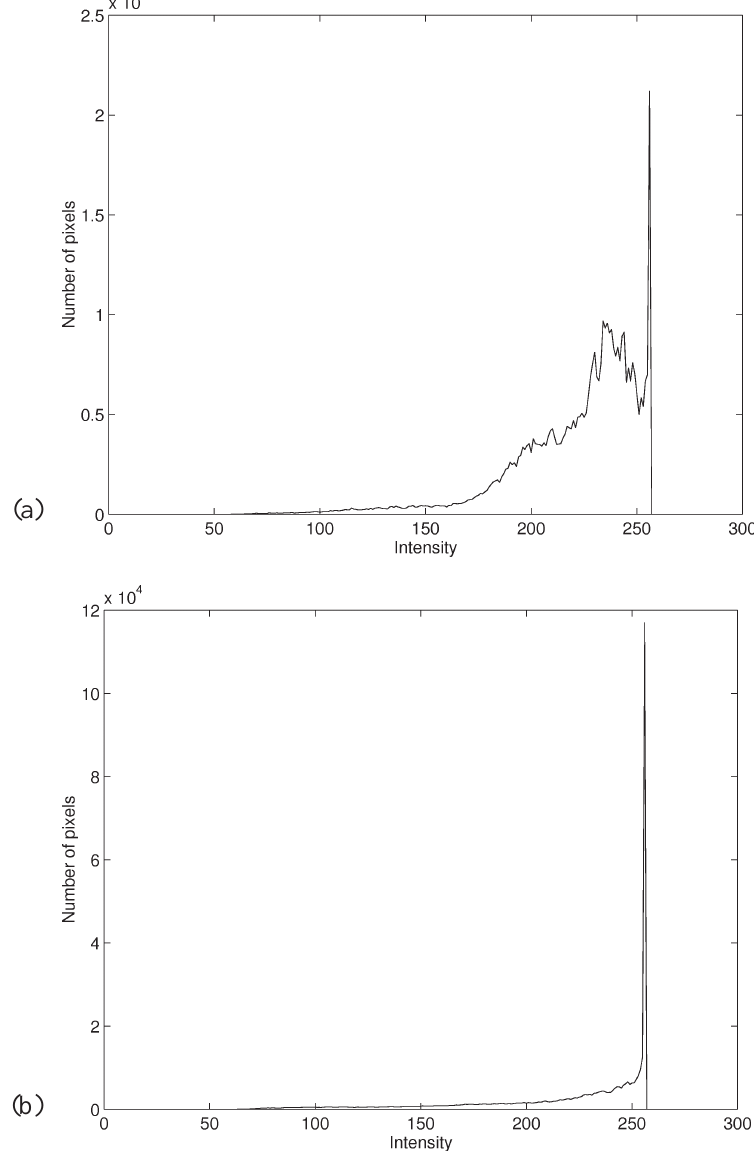
Fig. 2. Histogram of the first principal component for the images in Fig. 1. In this histogram and in all following histograms, the values on the x -axis are the intensity. Here the values on the y -axis are the corresponding number of